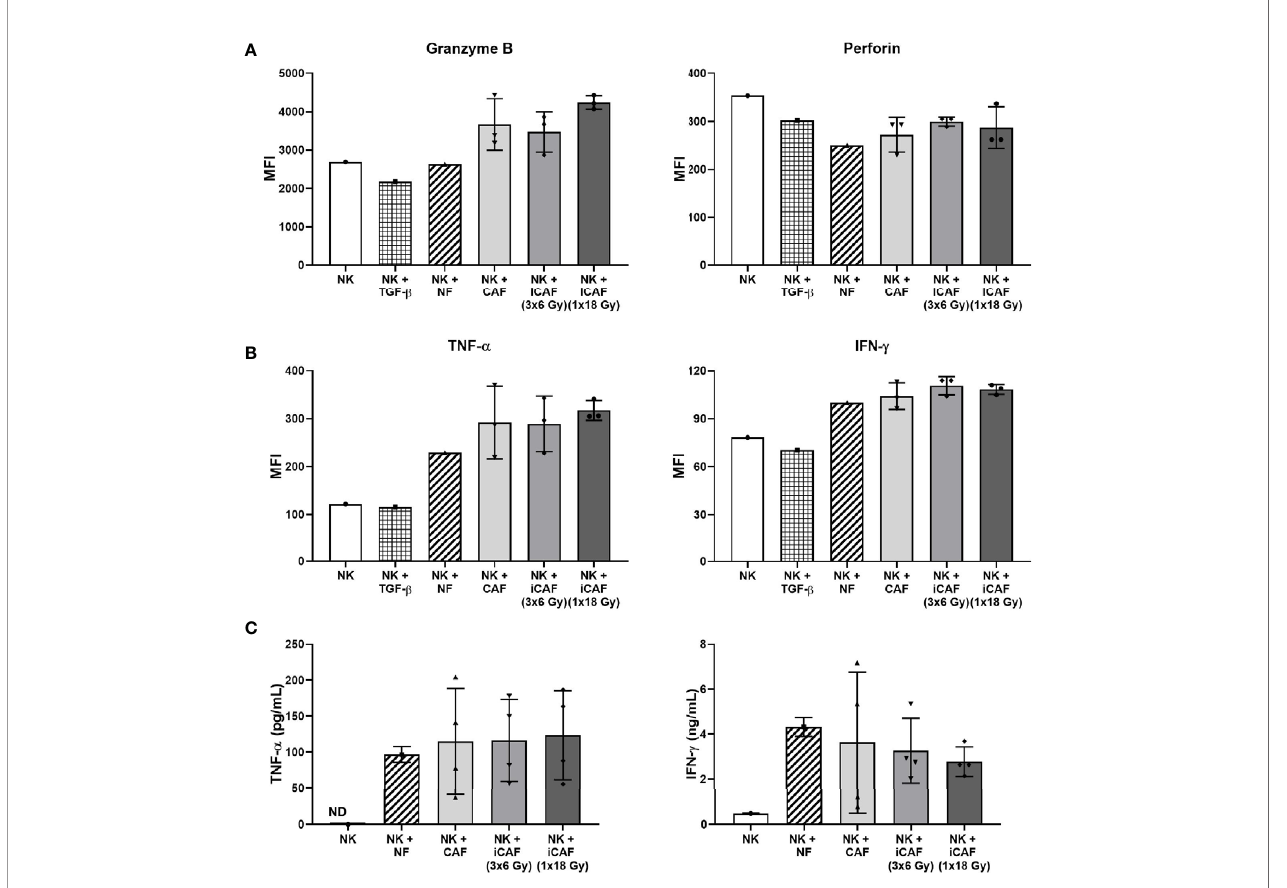
FIGURE 5 | Effects of cancer-associated fi broblasts (CAFs) on natural killer (NK) cell activation markers. NK cells were incubated in mixed cultures with NFs or CAFs. NK cells treated with TGF- b served as control of repressed functional activity. Following co-culturing, NK cells were analyzed for (A) intracellular expression of cytotoxic enzymes perforin and granzyme B after being employed against K562 cells (NK to K562 ratio 5:1); (B) intracellular expression of pro-in fl ammatory cytokines IFN- g and TNF- a after exposure to K562 cells (5:1); and (C) released levels of IFN- g and TNF- a in culture media ( fi broblast to NK ratio 1:2). Results in (A, B) were measured by fl ow cytometry, whereas cytokine release in (C) was quanti fi ed by ELISA. For intracellular markers, signal intensities are expressed as median fl uorescence intensity (MFI). Data represents mean (± SD) values from three different CAF donors. Statistical P -values between NF and CAFs were determined using one-way ANOVA with Tukey correction for multiple comparisons. Extracellular levels in (C) are presented as mean (± SD) values from four random CAF